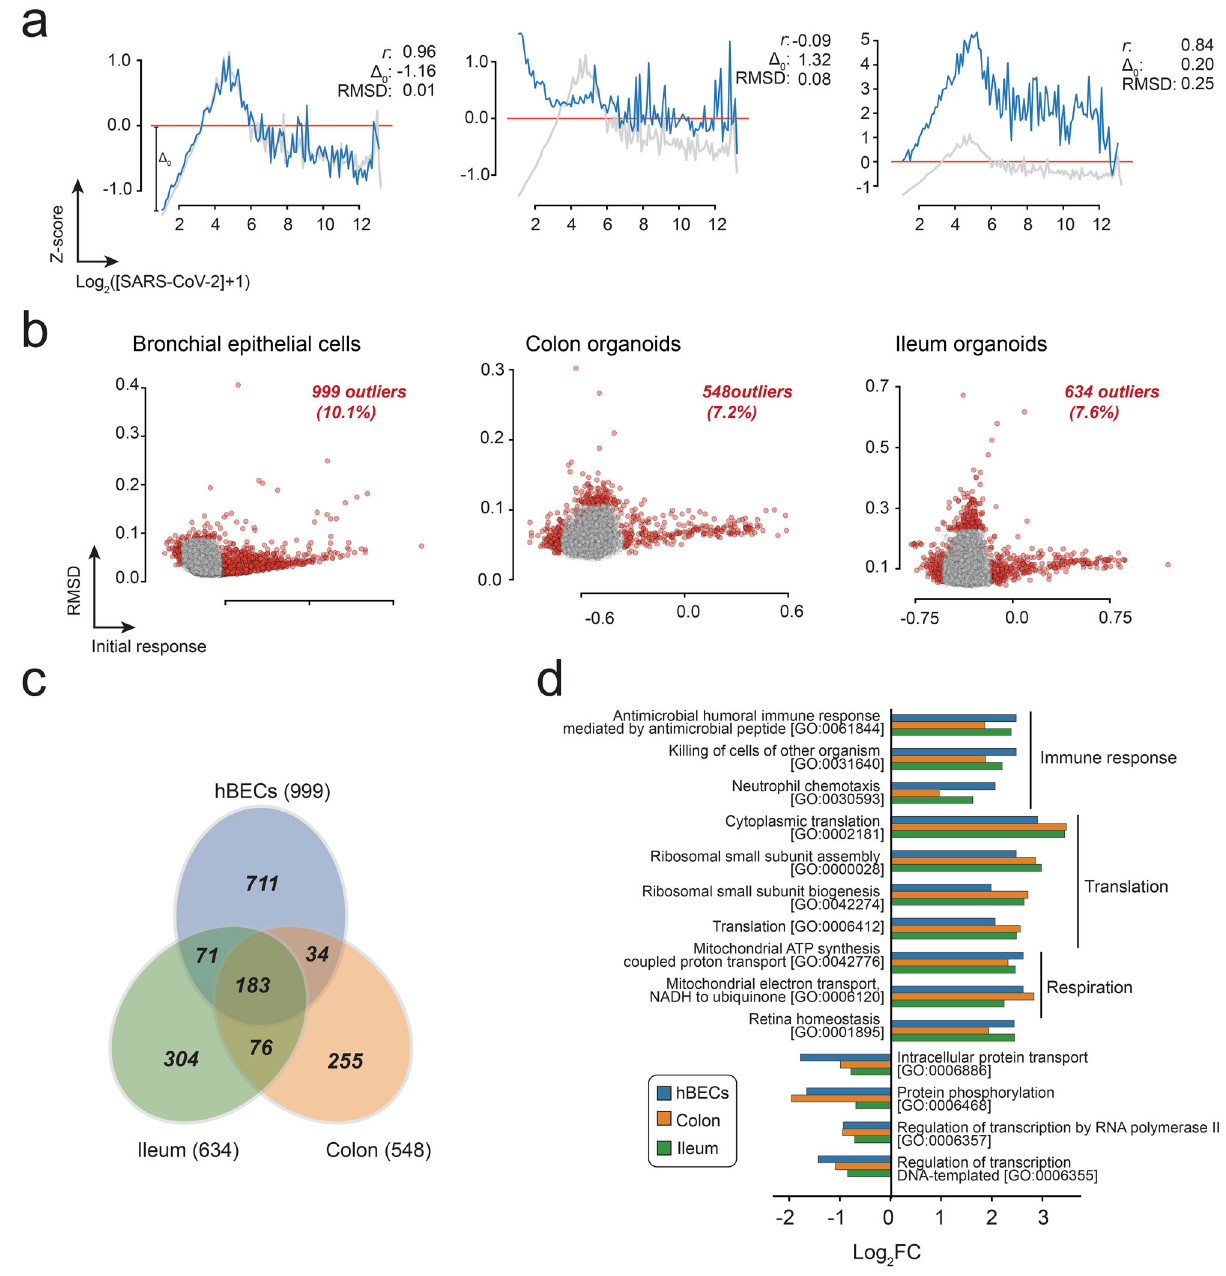
Fig. 2 Classi fi cation of genes based on their similarity to the mean response vector. a Examples of selected individual transcriptional pro fi les. Individual transcriptional responses (blue) were compared to the mean response (gray) using the root-mean-square deviation (RMSD) and the magnitude of the initial response ( Δ 0 ). The Pearson correlation ( r) for each comparison is also provided. b A plot of RMSD and initial response values for all genes, allows the identi fi cation of genes exhibiting abnormal transcriptional responses (outliers, red). c Venn diagrams illustrating the distribution of outliers among the three datasets used in the analysis. d GO-enrichment analysis of outliers from the three datasets indicating that most outliers correspond to genes involved in immune response, translation, and cellular